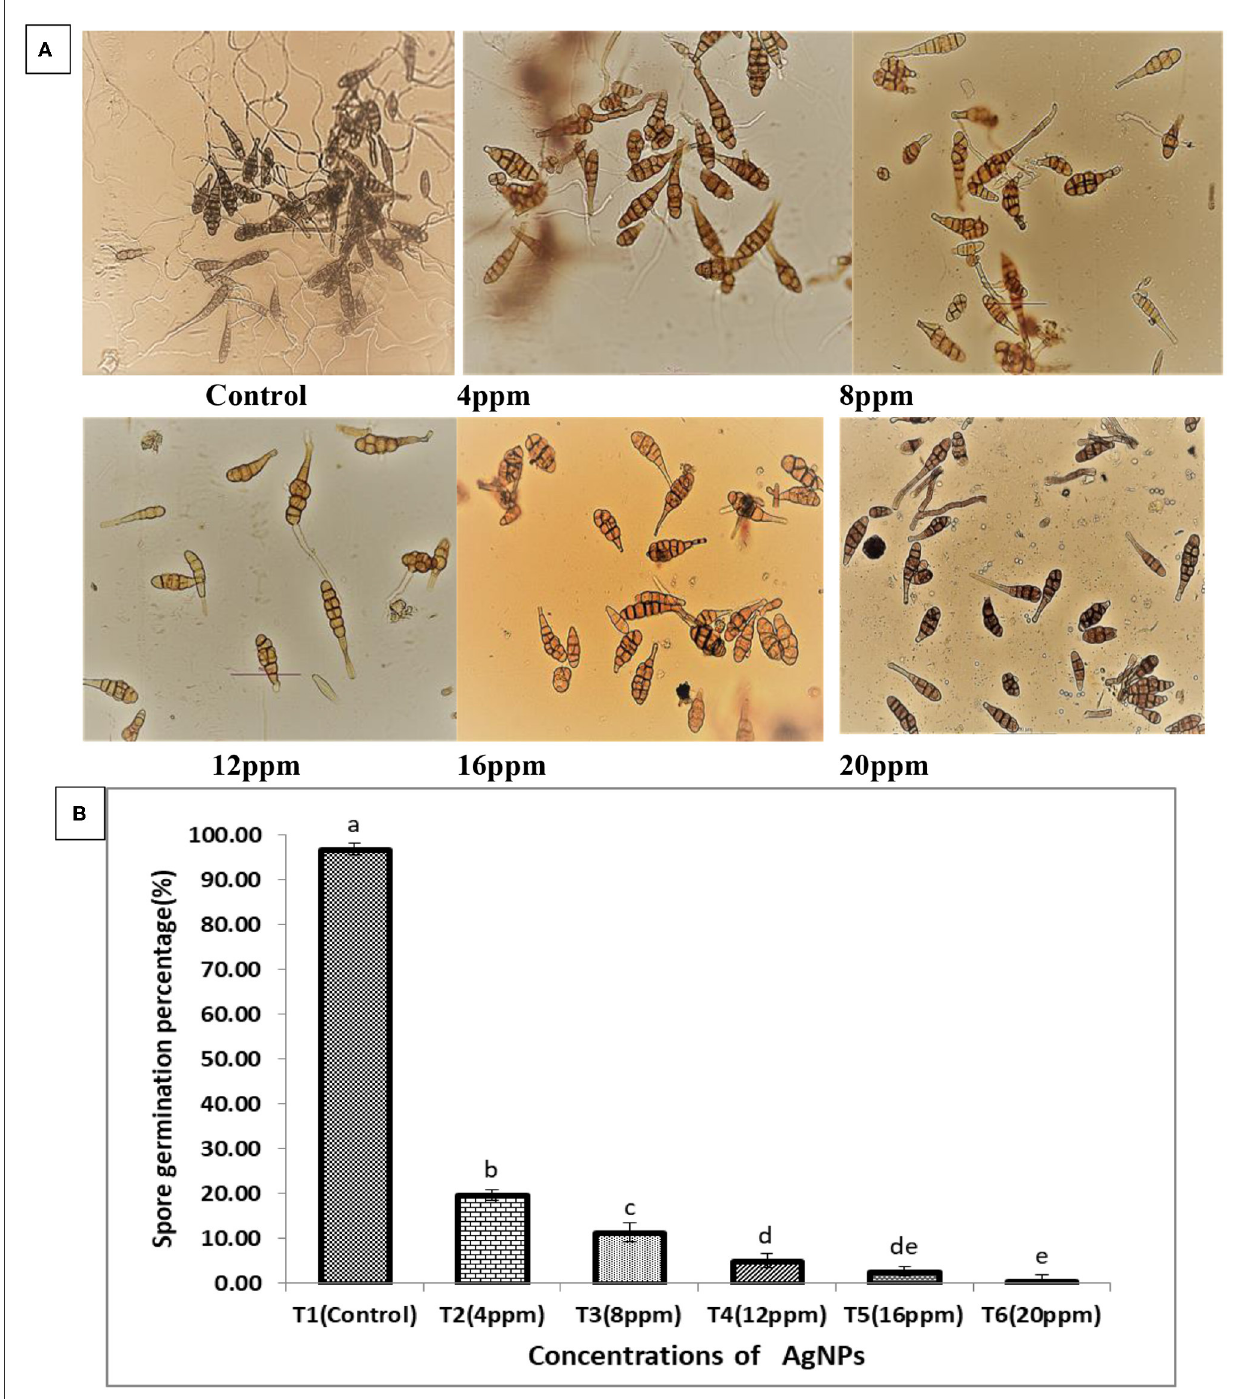
FIGURE9 (A) Effect of different concentrations of the synthesized Ag NPs on the spore germination rate of A. solani. (B) The mean of the three replicates of the results are presented as ± SE, and the vertical bars with different letters are significantly different when subjected to Duncan’s multiple range test ( p <